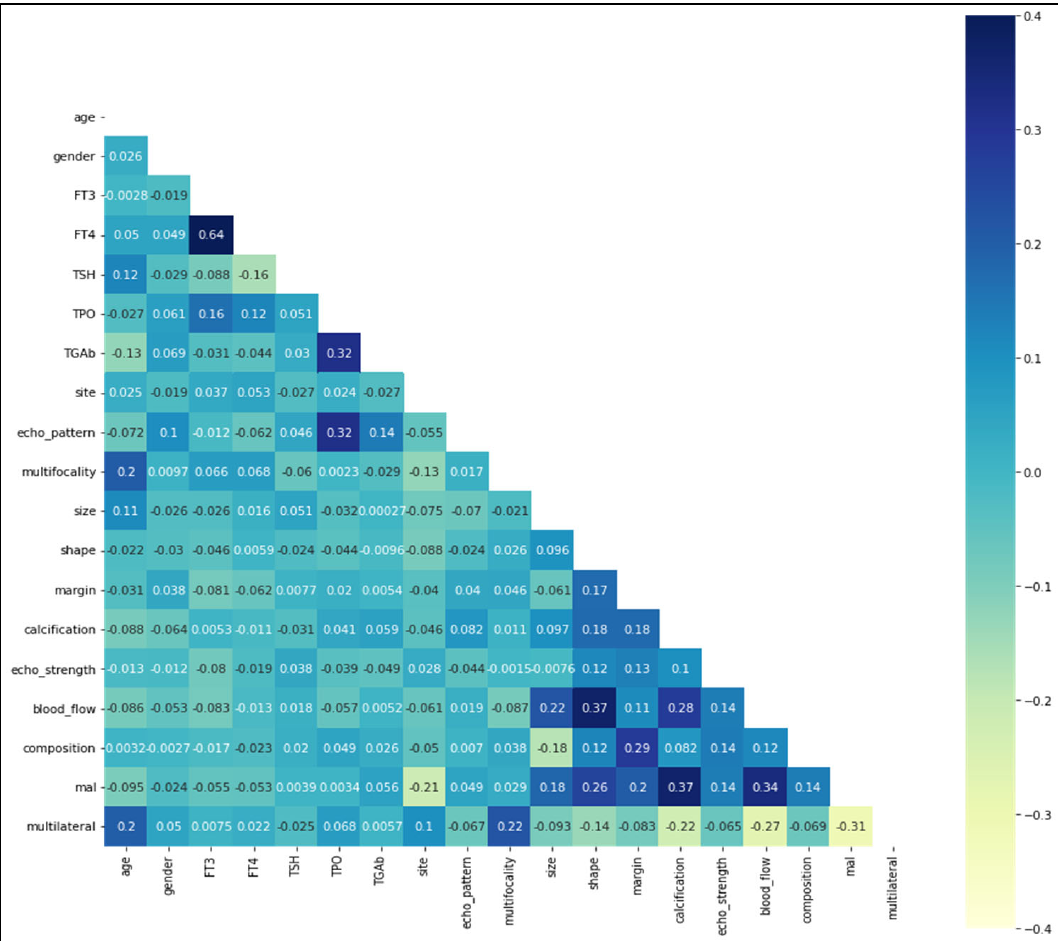
Figure 5. The data correlation of the 19 features.